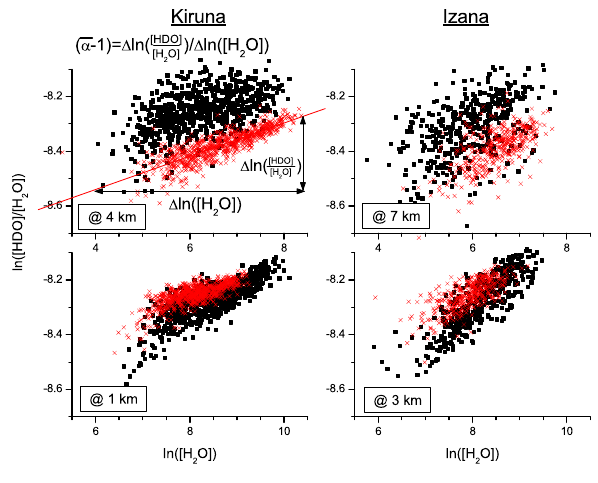
Fig. 5. Correlation between ln [ H 2 O ] amounts and the δ D values (expressed as ln [ HDO ] [ ), for the lower and middle troposphere (bot- H 2 O ] tom and top panels, respectively). Left panel: for Kiruna; Right panel: for Iza˜na. Black solid squares represent FTIR measurements and red crosses IsoGSM